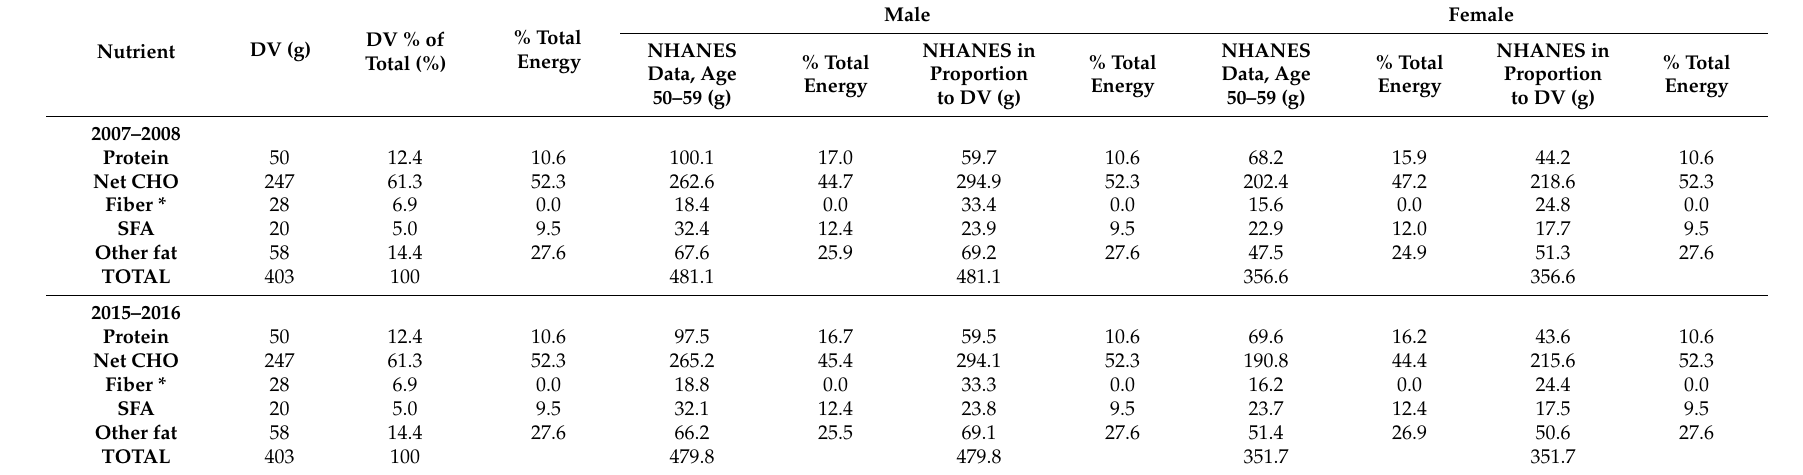
Table 6. Macronutrient Daily Values (DV) for males and females 51–70 years of age, the percentage contribution from each macronutrient to the total, the intakes from the National Health and Nutrition Examination Survey (NHANES) 2015–2016 for males and females aged 51–59 years, and the projected intake, per DV proportions, based on the total